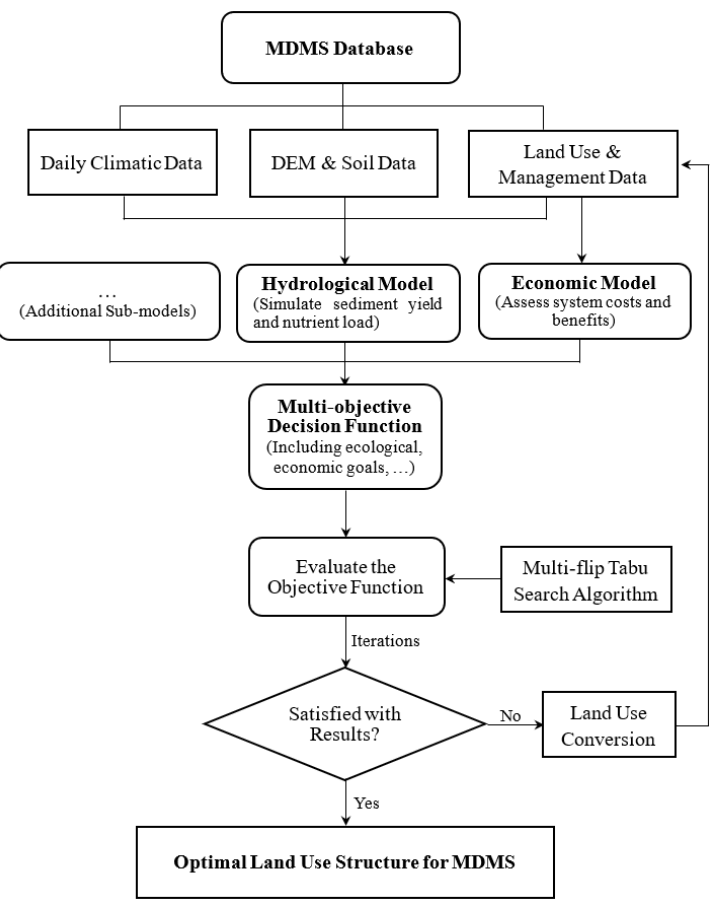
Figure 1. MDMS framework for agricultural land use optimization based on coupling modeling.